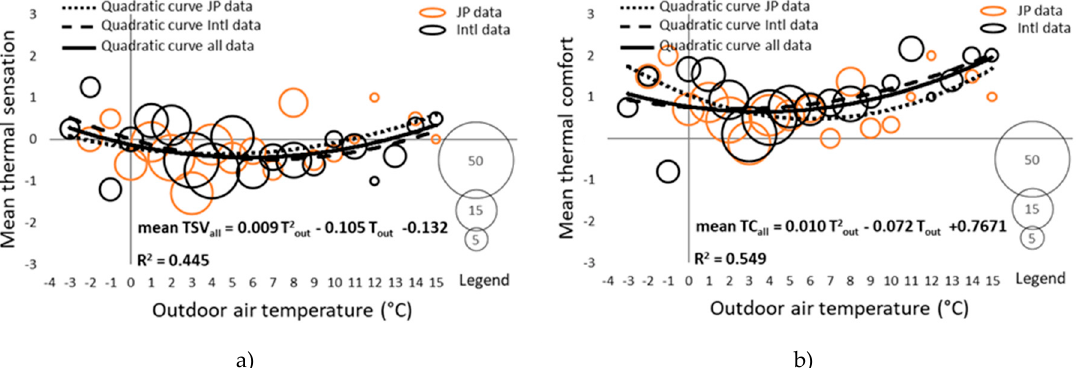
Figure 8. Relationship between mean values of thermal responses to the outdoor temperature. ( a ) Mean TSV: T out ; ( b ) mean TC: T out .